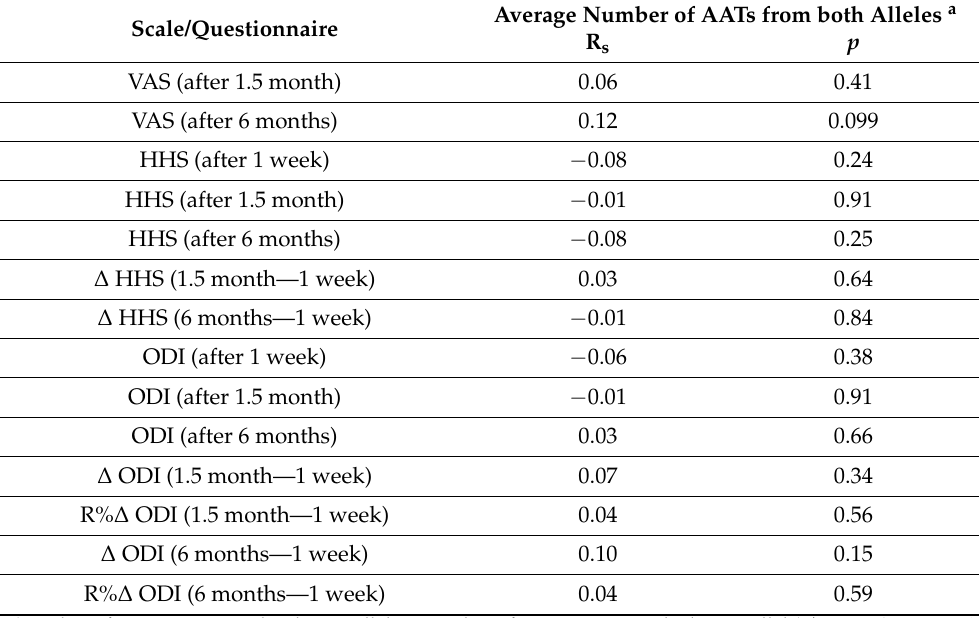
Table 11. The correlations between the average number of AAT repeats in the CNR1 gene from both alleles, pain intensity, hip function, and the degree of disability in patients at defined